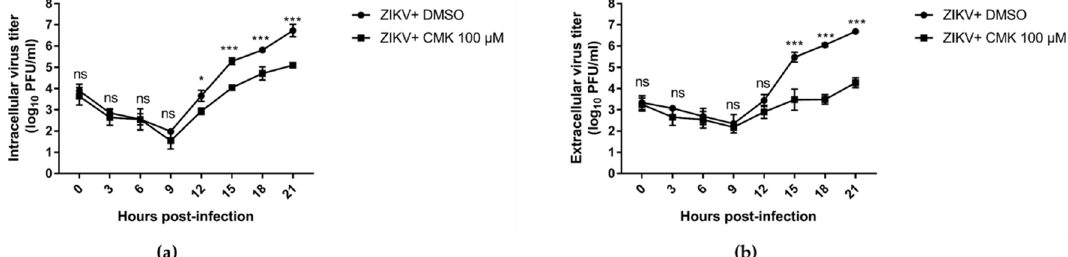
Figure 6. Dec-RVKR-cmk inhibits ZIKV infection in the one-step growth cycle. Vero cells were infected with ZIKV at an MOI of 5 for 1 h followed by dec-RVKR-cmk or DMSO treatment after washing the cells. At the indicated time points after infection, culture medium was collected and cells were subjected to three freeze-thaw cycles to liberate cell-associated viruses. ( a ) Intracellular and ( b ) extracellular virus titer was determined by plaque assay. Data are presented as the mean ± SEM from three independent experiments.